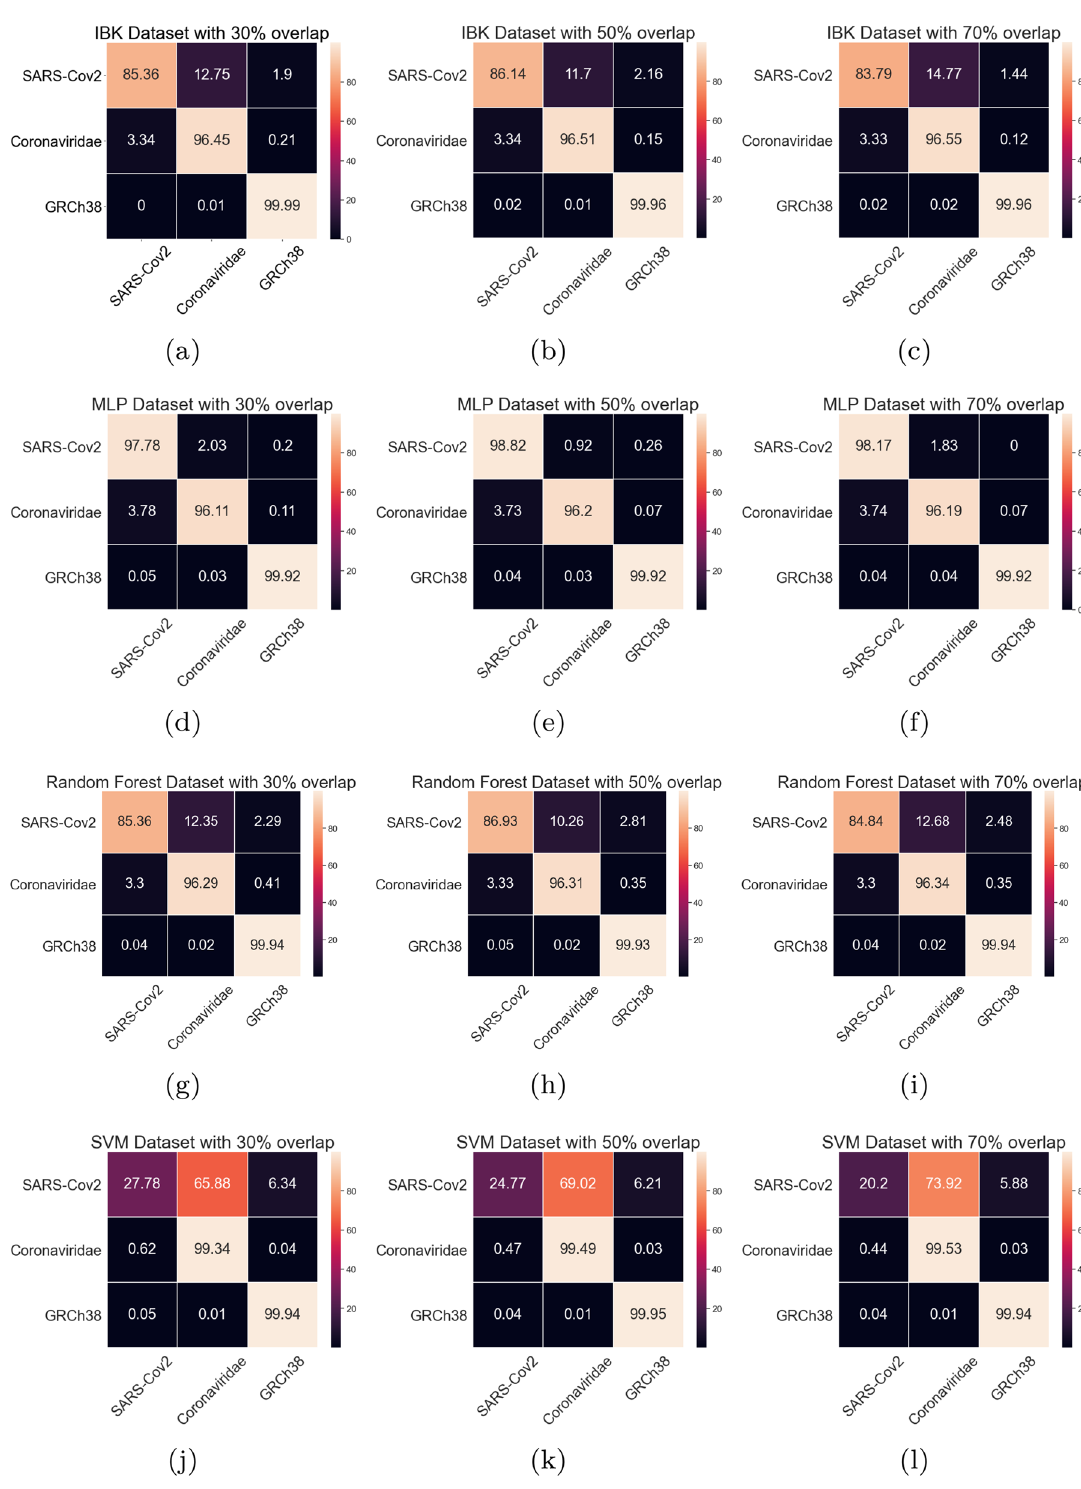
Figure 19. Average Confusion matrices for IBK, MLP, Random Forest and SMV in the SARS-CoV-2 test